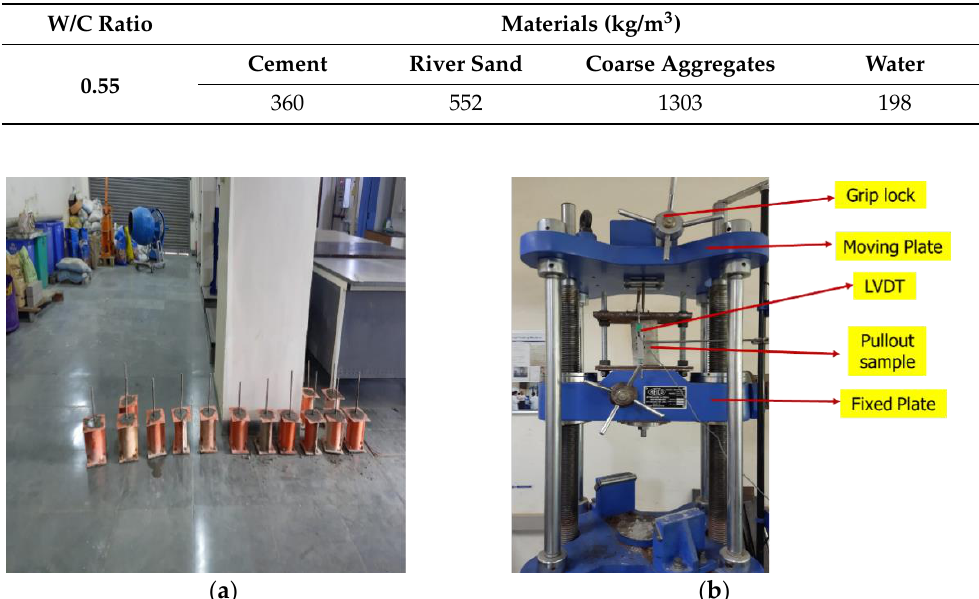
Table 1. Mix proportion of concrete.